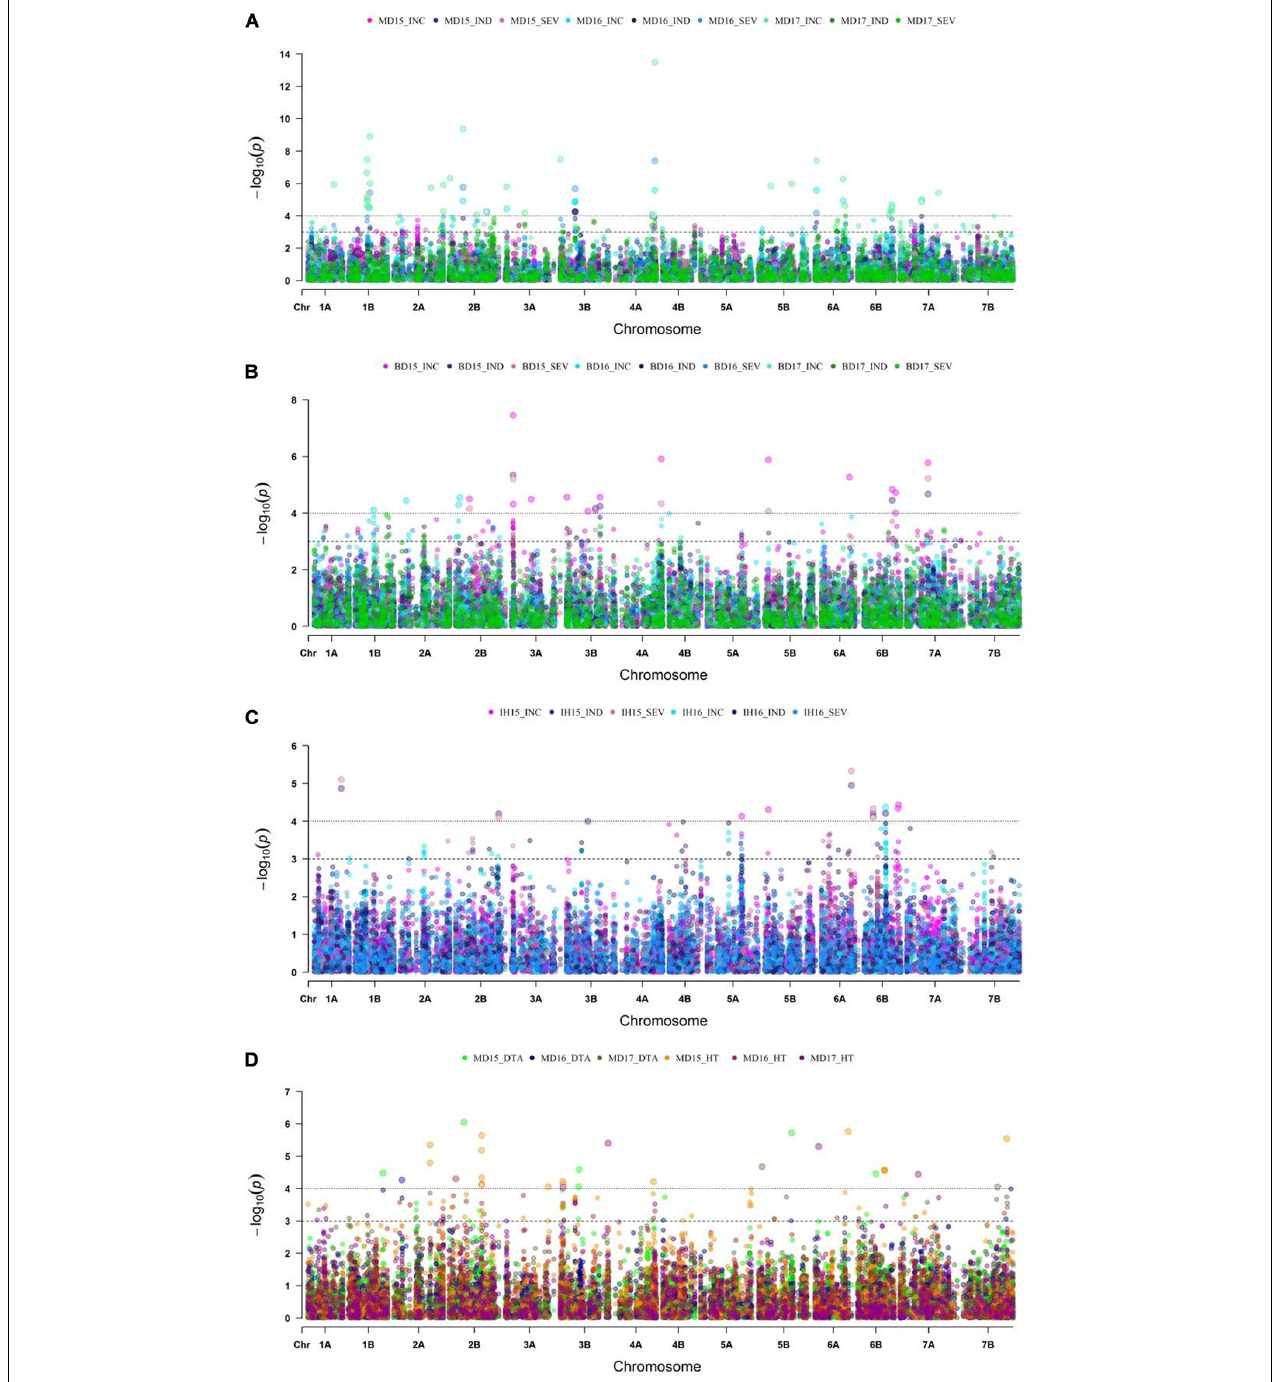
FIGURE 4 | Manhattan plots displaying genome wide marker-trait association analysis for FHB incidence (INC), index (IND) and severity (SEV) at (A) Morden, MB from the years 2015 to 2017; (B) Brandon, MB for years 2015 to 2017; (C) Indian Head, SK from 2015 to 2016 (with natural infection); and for (D) plant height (HT) and day to anthesis (DTA) at Morden, MB for 2015 to 2017